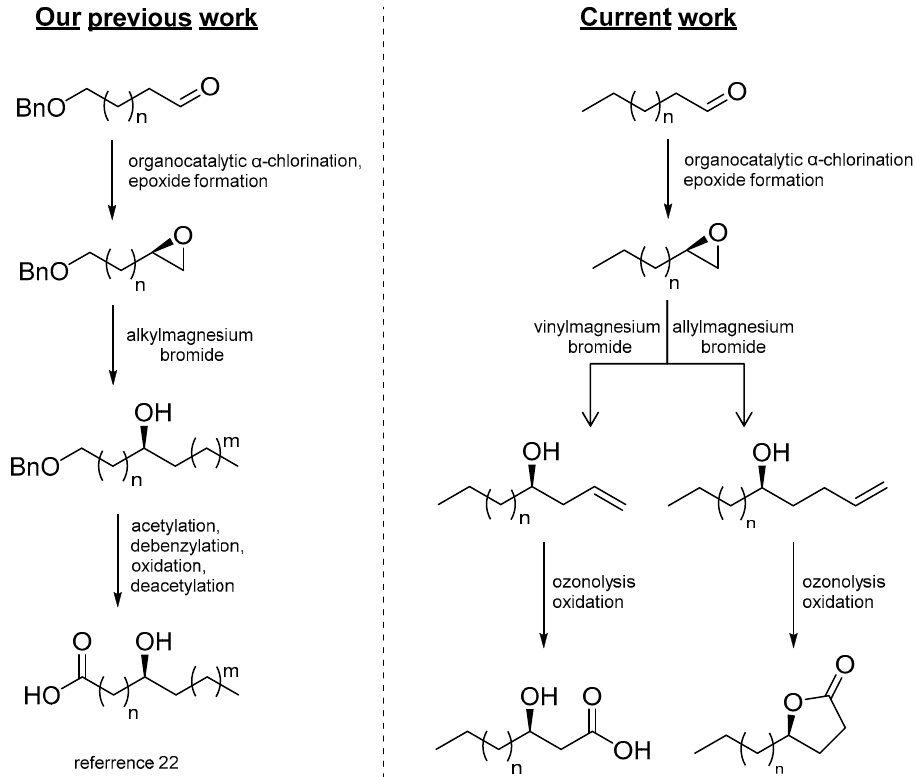
Figure 1. Previous work for the synthesis of 9-hydroxy fatty acids [22] ( left ) and current design plan for the synthesis of 3-hydroxy fatty acids or 4-hydroxy fatty acid derivatives ( right ).